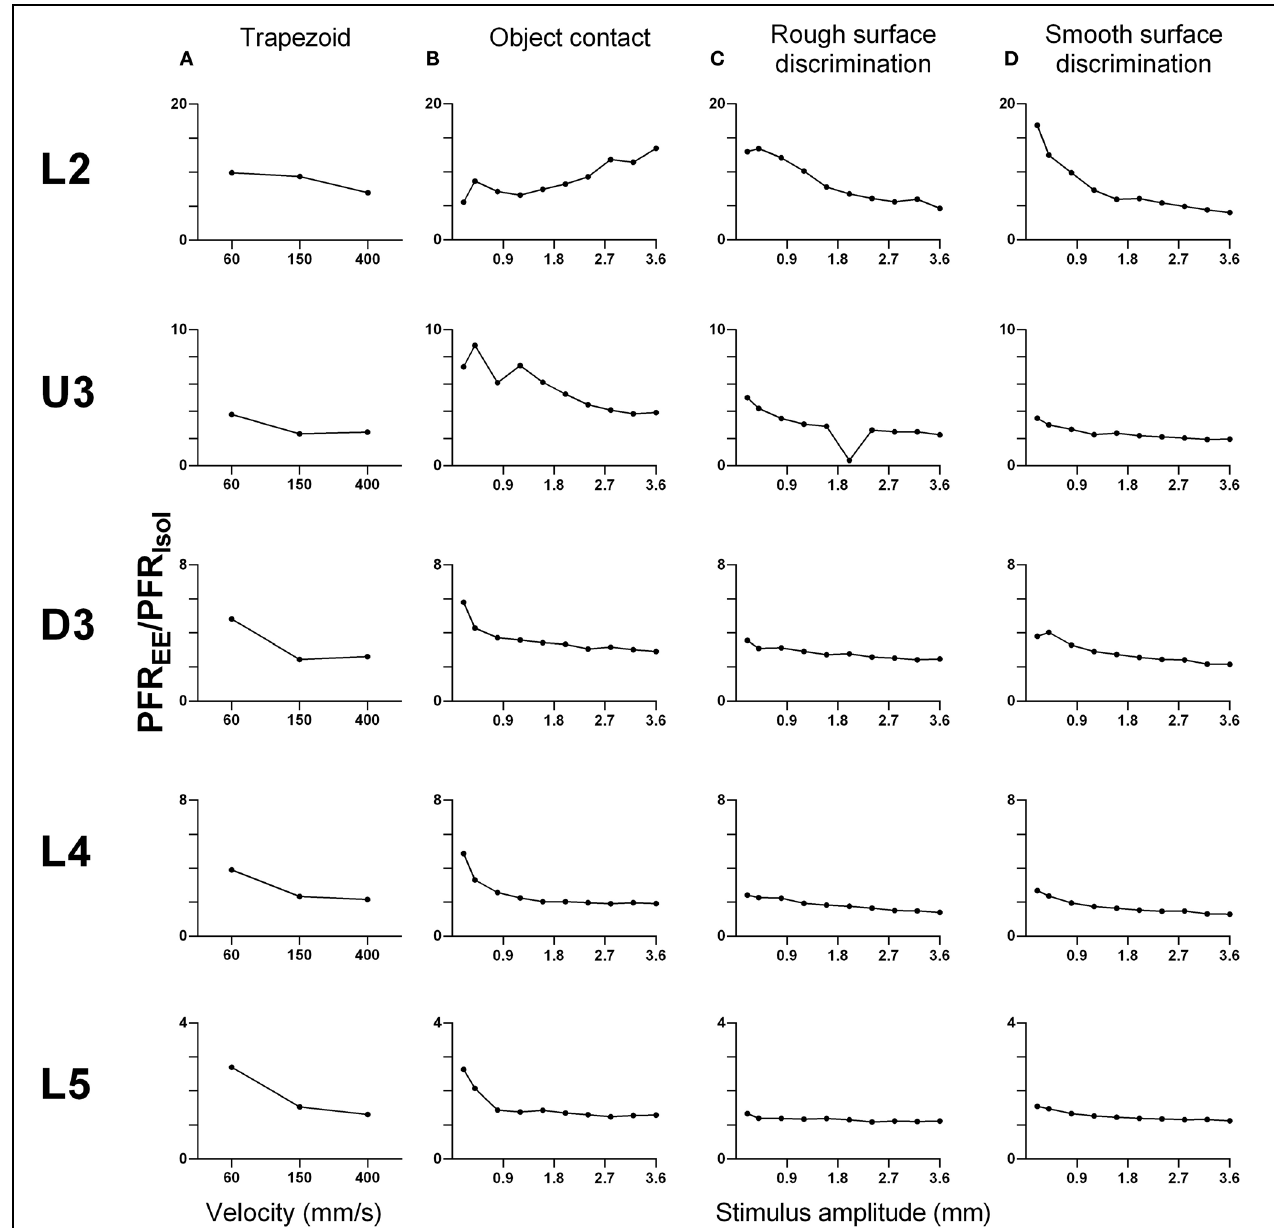
greatest at lower velocities/amplitudes and decreased with increasing velocity/amplitude in all cortical layers as responses in EE animals came closer to those in Isolation-housed animals. Laminar designations: L2, Layer 2; U3, Upper Layer 3; D3, Deep Layer 3; L4, Layer 4; L5, Layer 5. Each row of data comes from the same lamina as designated by the labels on the